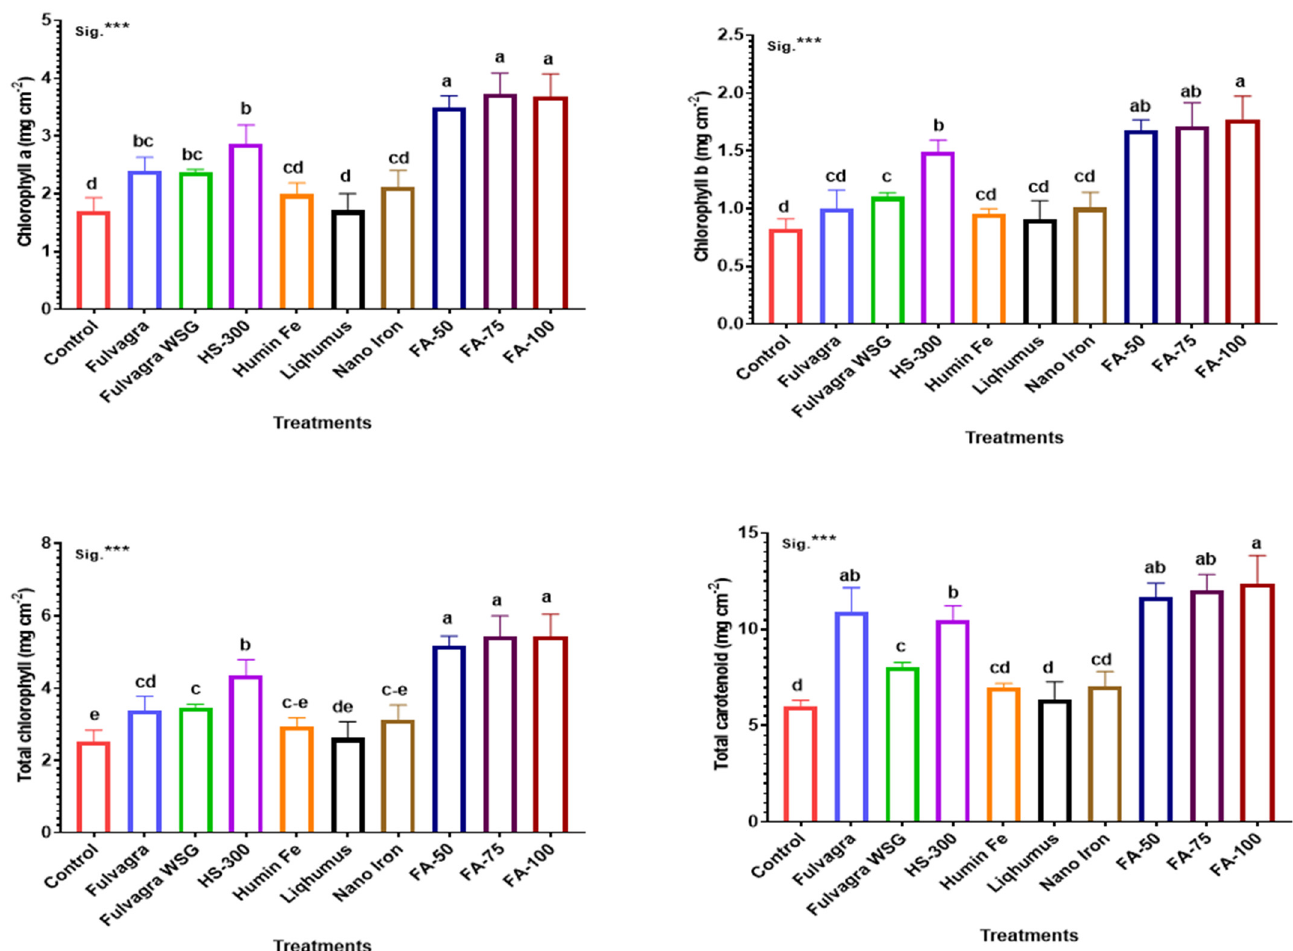
Figure 5. The effects of different treatments on chlorophyll a, chlorophyll b, total chlorophyll, and total carotenoid contents spinach. Treatments Fulvagra, Fulvagra WSG, HS-300, Humin Fe, and Liqhumus contain FeSO 4 ·7H 2 O; treatments Nano Iron, FA-50, FA-75, and FA-100 contain nano ferrihydrite. The iron concentration in all treatments is 20 mM. The mean values with the same letter within the same column are not significantly different (***: p > 0.001).